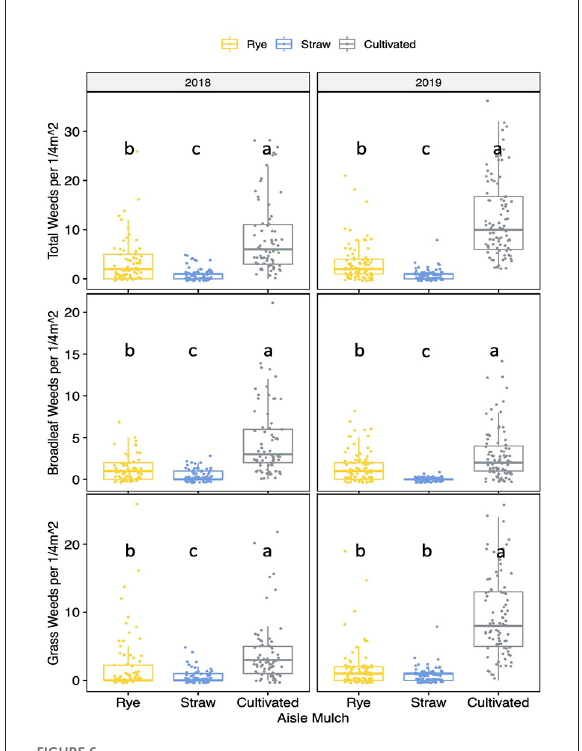
FIGURE6 Total (Top) , broadleaf (Middle) and grass (Bottom) weed counts per 0.25 m 2 , 2018 and 2019. Lowercase letters indicate significance groupings for aisle mulch within a given year. Groups with the same letter were not significantly different at p <